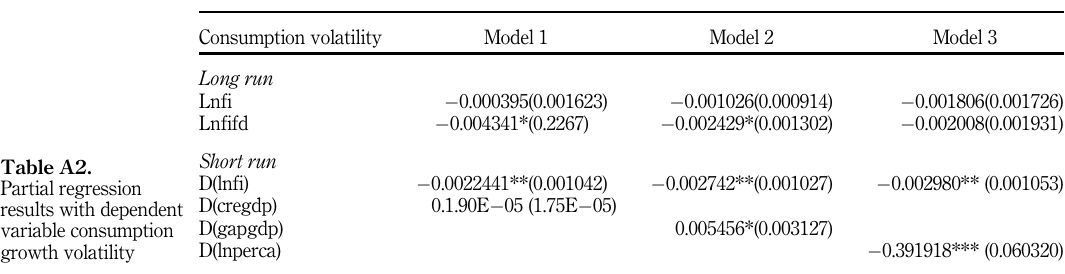
results with dependent variable output growth volatility